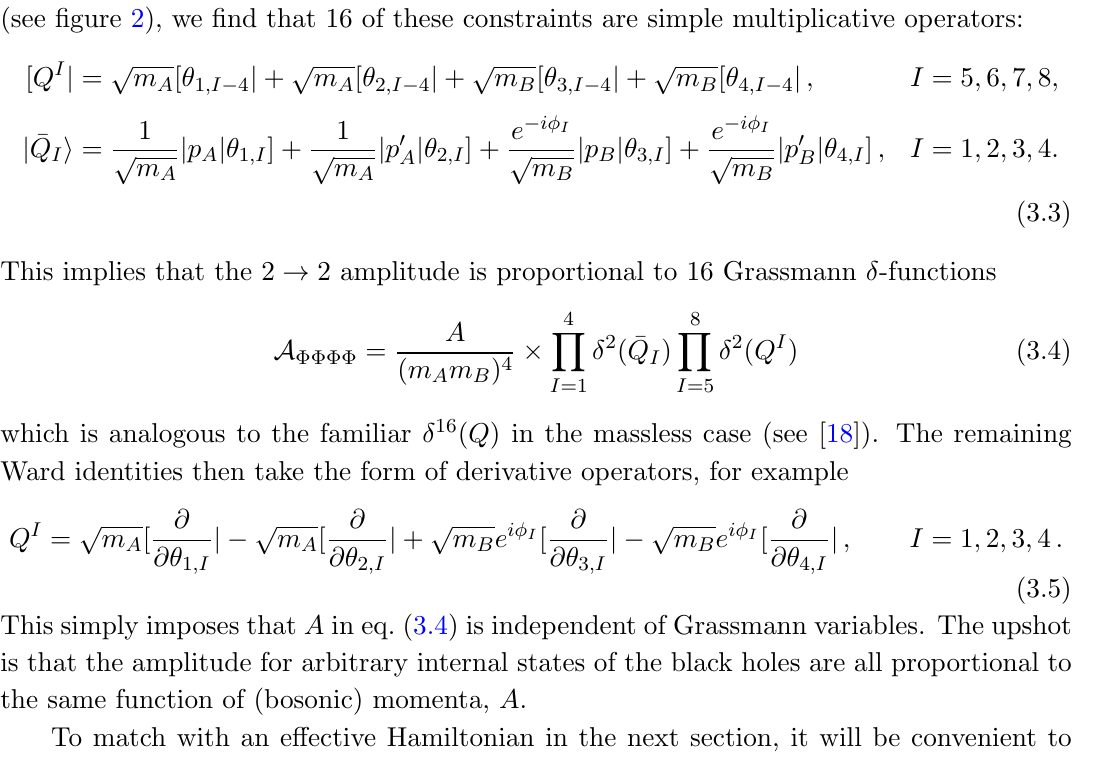
2 scattering of black holes. Time runs →